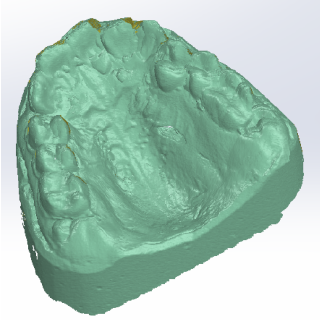
Figure 5. Scanned image of the maxillary arch.